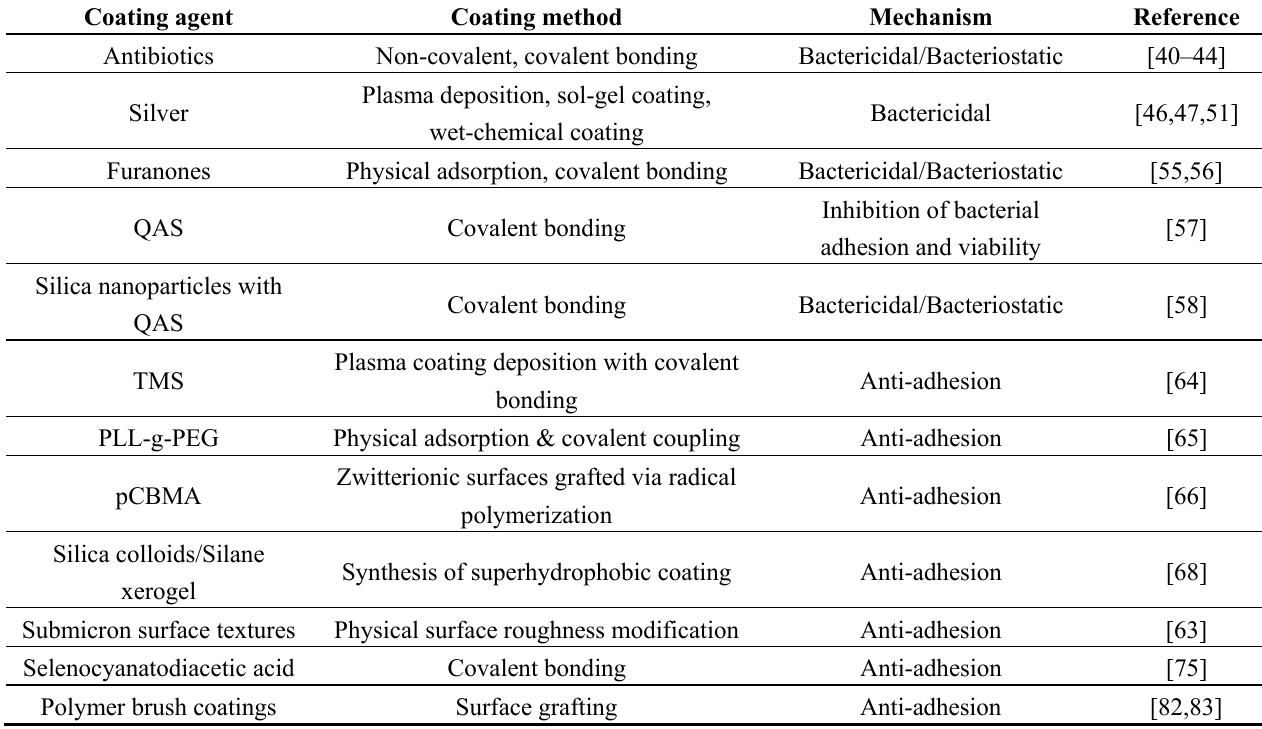
Table 2. Surface modification approaches that can inhibit biofilm